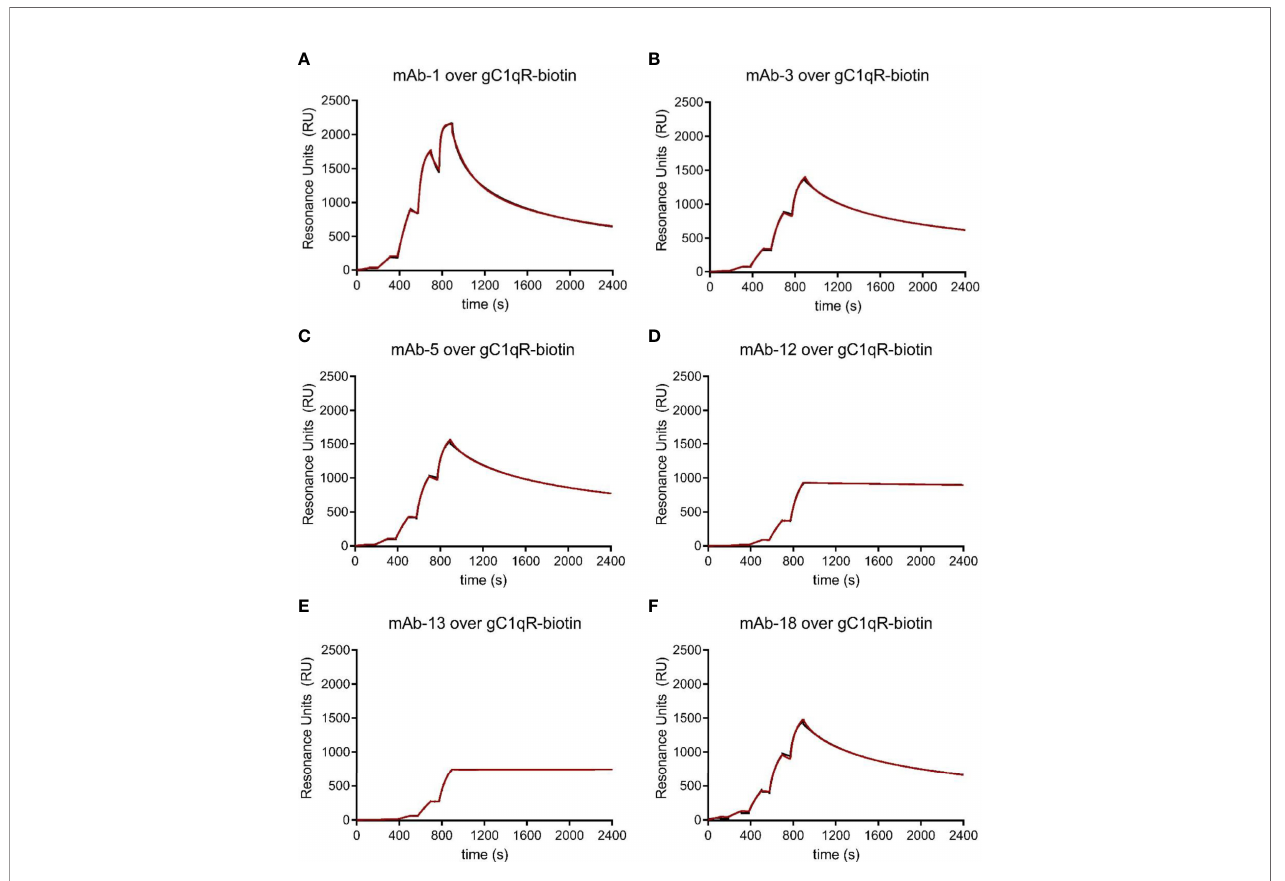
FIGURE 3 | Characterization of a Novel Panel of anti-gC1qR Monoclonal Antibodies. Puri fi ed anti-gC1qR monoclonal antibodies were prepared from ascites fl uid and their interactions with chemically biotinylated gC1qR were assessed by surface plasmon resonance. (A) Reference-corrected sensorgram from a single cycle kinetic study where a fi ve-fold dilution series of mAb-1 (1 m M highest concentration) was injected over a surface of biotinylated gC1qR. The black trace represents the experimental data, while the red line represents the outcome of fi tting to a bivalent analyte kinetic model. (B) Identical to panel (A) , except for mAb-3 served as the analyte. (C) Identical to panel (A) , except for mAb-5 served as the analyte. (D) Identical to panel (A) , except for mAb-12 served as the analyte. (E) Identical to panel (A) , except for mAb-13 served as the analyte. (F) Identical to panel (A) , except for mAb-18 served as the